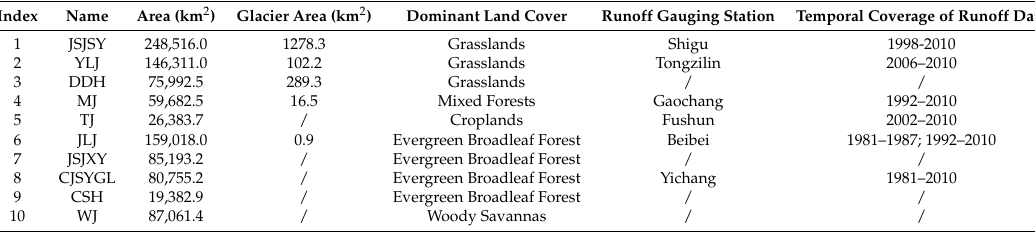
Table 1. Characteristics of the ten sub-regions in the Upper Changjiang River Basin. Dominant land cover type was retrieved from [28], glacier area was retrieved from [27], and temporal series of runoff are shown at six runoff gauging